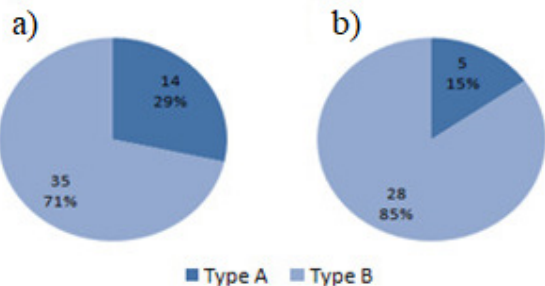
Figure 4. Classification of cyclones as type A and B for: a) MERRA-2; b)